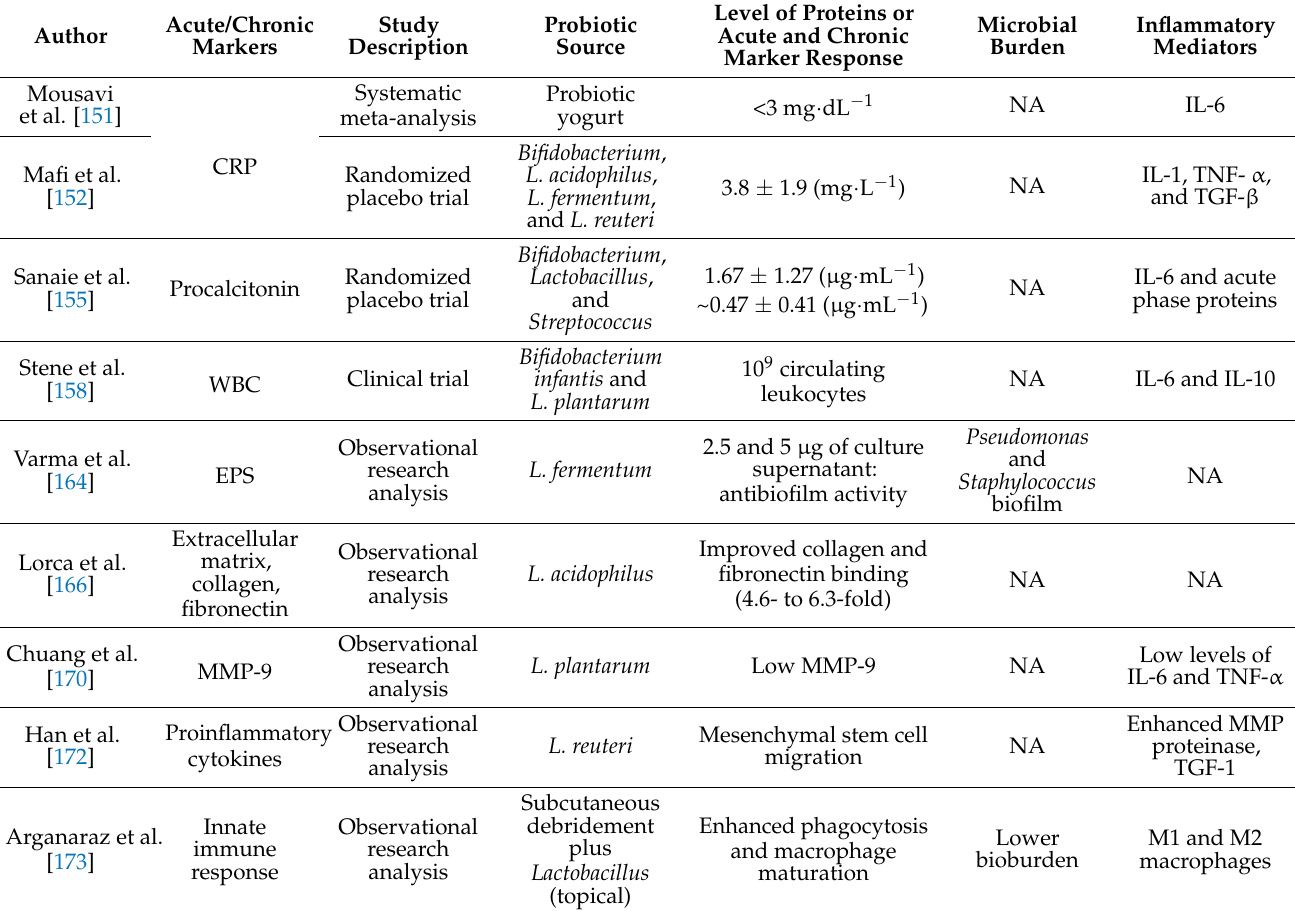
Table 2. Features of probiotic studies associated with acute and chronic